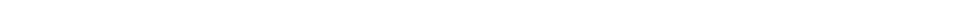
(see fi gure on previous page) Fig. 1 P56S-VAPB leads to defective autophagy in ALS8. a Representative H&E stained section from ALS8 index patient muscle biopsy showing typical neurogenic atrophy; presence of angular, fl atten and group fi bre atrophy. Scale bar: 60 µm. b Prominent immunoreactivity of globular VAPB aggregates (arrowheads, right panels) in grouped angular or fl attened, atrophic, denervated muscle fi bres of ALS8 compared to the normal control (left panel) showing diffuse pattern of sarcomeric VAPB immunolabelling in normal-sized fi bres. Scale bars: 70 µm. c Immunolabeling of human fi broblasts using VAPB antibody showing small but enormous punctate P56S-VAPB aggregates in ALS8 fi broblast (right panel, white arrowheads), compared to control (left panel). Note the increased formation of globular P56S-VAPB aggregates (arrowheads) in ALS8 fi broblasts, after treatment with proteasome inhibitor MG132 (2 µM) and Ba fi lomycin A (200 nM) for 4 h. Scale bars: 10 µm. d DAB immunohistochemistry performed on ALS8 muscle biopsy showing increased accumulation of autophagy marker p62 and LC3 in atrophic and partially atrophic fi bres. Note the numerous large autophagic vacuoles (white arrows) present in hypertrophic fi bres. Scale bars: 50 µm. e Double immuno fl uorescence labelling of ALS8 muscle biopsy using antibodies against VAPB and for the autophagy marker p62 and LC3 showing co-localisation of the aggregated p62 and LC3 together with the mutant VAPB aggregates. Scale bars: 25 µm. f Punctate P56S-VAPB aggregates co-localised with LC3 and p62 accumulations in ALS8 fi broblasts. Scale bars: 10 µm. g Immunoblot analysis in NSC-34 cells transiently transfected either with empty GFP vector, wt-VAPB and P56S-VAPB. Note the increased levels of ER stress, autophagy markers as well as presence of gel top smear aggregate of P56S-VAPB (black arrowhead) and aggregated p62 (red arrowhead) in P56S-VAPB expressing cells. Corresponding densitometric data are shown at the bottom; representing the relative band intensity of LC3-II/LC3-I, normalised with tubulin levels. Graph pad prism, unpaired Student ’ s t test for comparison between two sample groups. Values were expressed as mean ± standard error of mean (SEM) from three independent experiments. The asterisks denote signi fi cant differences (* p < 0.05). h , i Co-labelling of wt-VAPB and P56S-VAPB with LC3 ( h ) and with p62 ( i ). Note that the globular accumulations of both LC3 and p62 and their co- localisation with P56S aggregates. Scale bar: 10 µm. j , k Increased accumulation of autophagosomes (white arrowheads) in the stable autophagy reporter cell line NIH3T3-GFP transfected with P56S-VAPB. Green: GFP-LC3; red: VAPB; scale bar: 10 µm ( j ). Immunoblot analysis showing increased levels of both p62 and LC3 in cells transfected with P56S-VAPB ( k ). Unpaired Student ’ s t test for comparison between two sample groups. Values were expressed as mean ± standard error of mean (SEM) from three independent experiments. The asterisks denote signi fi cant differences (* p < 0.05). l Immunoblot analysis of A431 cells transfected with EGFP, wt-VAPB and P56S-VAPB showing the increased levels of the autophagy markers EGFR, p62 and LC3 in P56S-VAPB expressing cells. Unpaired Student ’ s t-test for comparison between two sample groups. Values were expressed as mean ± standard error of mean (SEM) from three independent experiments. The asterisks denote signi fi cant differences (* p < 0.05). m A431 cells were transfected as described above. 24 h later, transfected cells were processed for the EGFR degradation assay (see Methods) and analysed by immunoblotting with the EGFR antibody. Note the delayed EGFR degradation in P56S-VAPB expressing cells. Right panel: quanti fi cation of immunoblots analysis. Graph pad prism, unpaired Student ’ s t test for comparison between two sample groups. Values were expressed as mean ± standard error of mean (SEM) from three independent experiments. The asterisks denote signi fi cant differences (* p < 0.05), while # denotes absence of a signi fi cant difference. n NSC-34 cells overexpressing wt-VAPB and P56S-VAPB were fi xed with 2.5% buffered glutaraldehyde and processed for EM. Several membrane-bound vacuolar structures (white arrows) often containing cargoes and probably derived from the ER in a representative P56S-VAPB-expressing cell compared to cells expressing wt-VAPB control. Higher magni fi cation showing the ER membrane proliferation into tubular structures (black arrow; lower left panel), and large autophagic vacuoles often fi lled with cargoes (white arrow; lower panel) in representative P56S- VAPB expressing cells. Scale bars: 1 µm (upper panel), 0.5 µm (lower